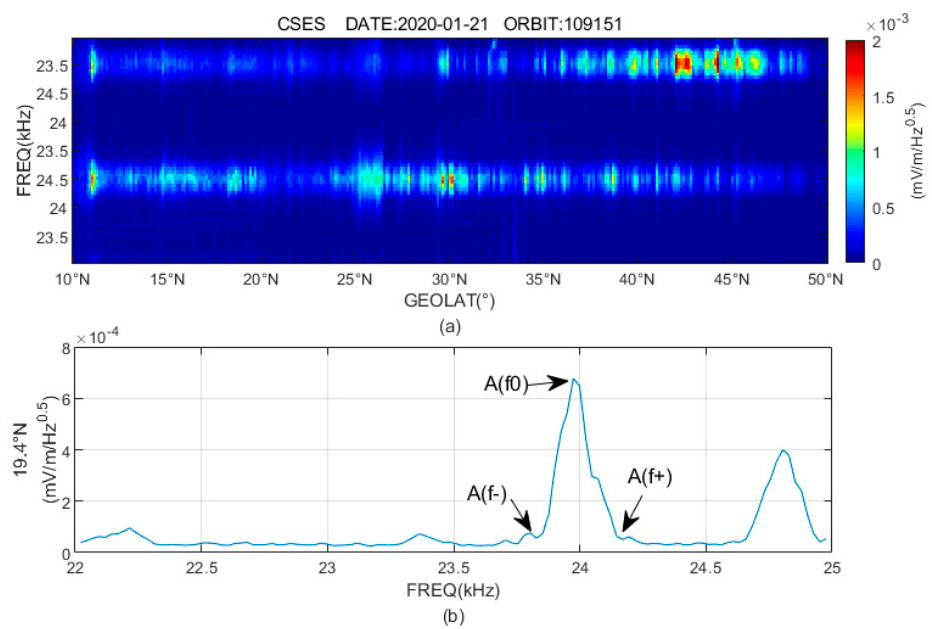
Figure 2. The power spectrum of the E-ab component of the 109,501 orbital electric field. Two distinct spectral lines can be seen in Figure 2a. The more energetic line in the figure represents the NAA transmitting station (24 kHz), and the weaker line above it represents the NLK transmitting station (24.8 kHz). Figure 2b represents the frequency variation plot of 22–25 kHz at the location of the epicenter at the geographic latitude